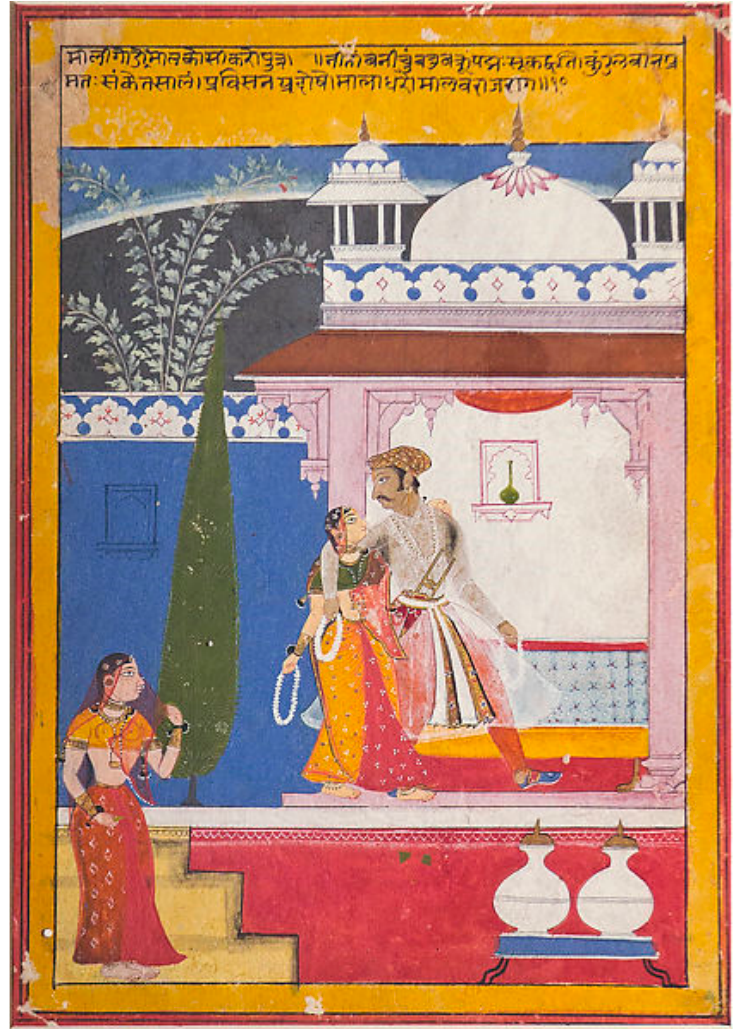
Figure 7. Malavi Ragini: Folio from a Ragamala Series , Artist: Sahibdin, 1628 CE, opaque watercolor and ink on paper. The Metropolitan Museum of Art, New York, Lent by Private Collection.